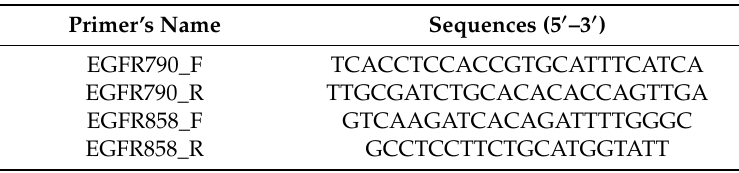
Table 1. Sequences for PCR primers.